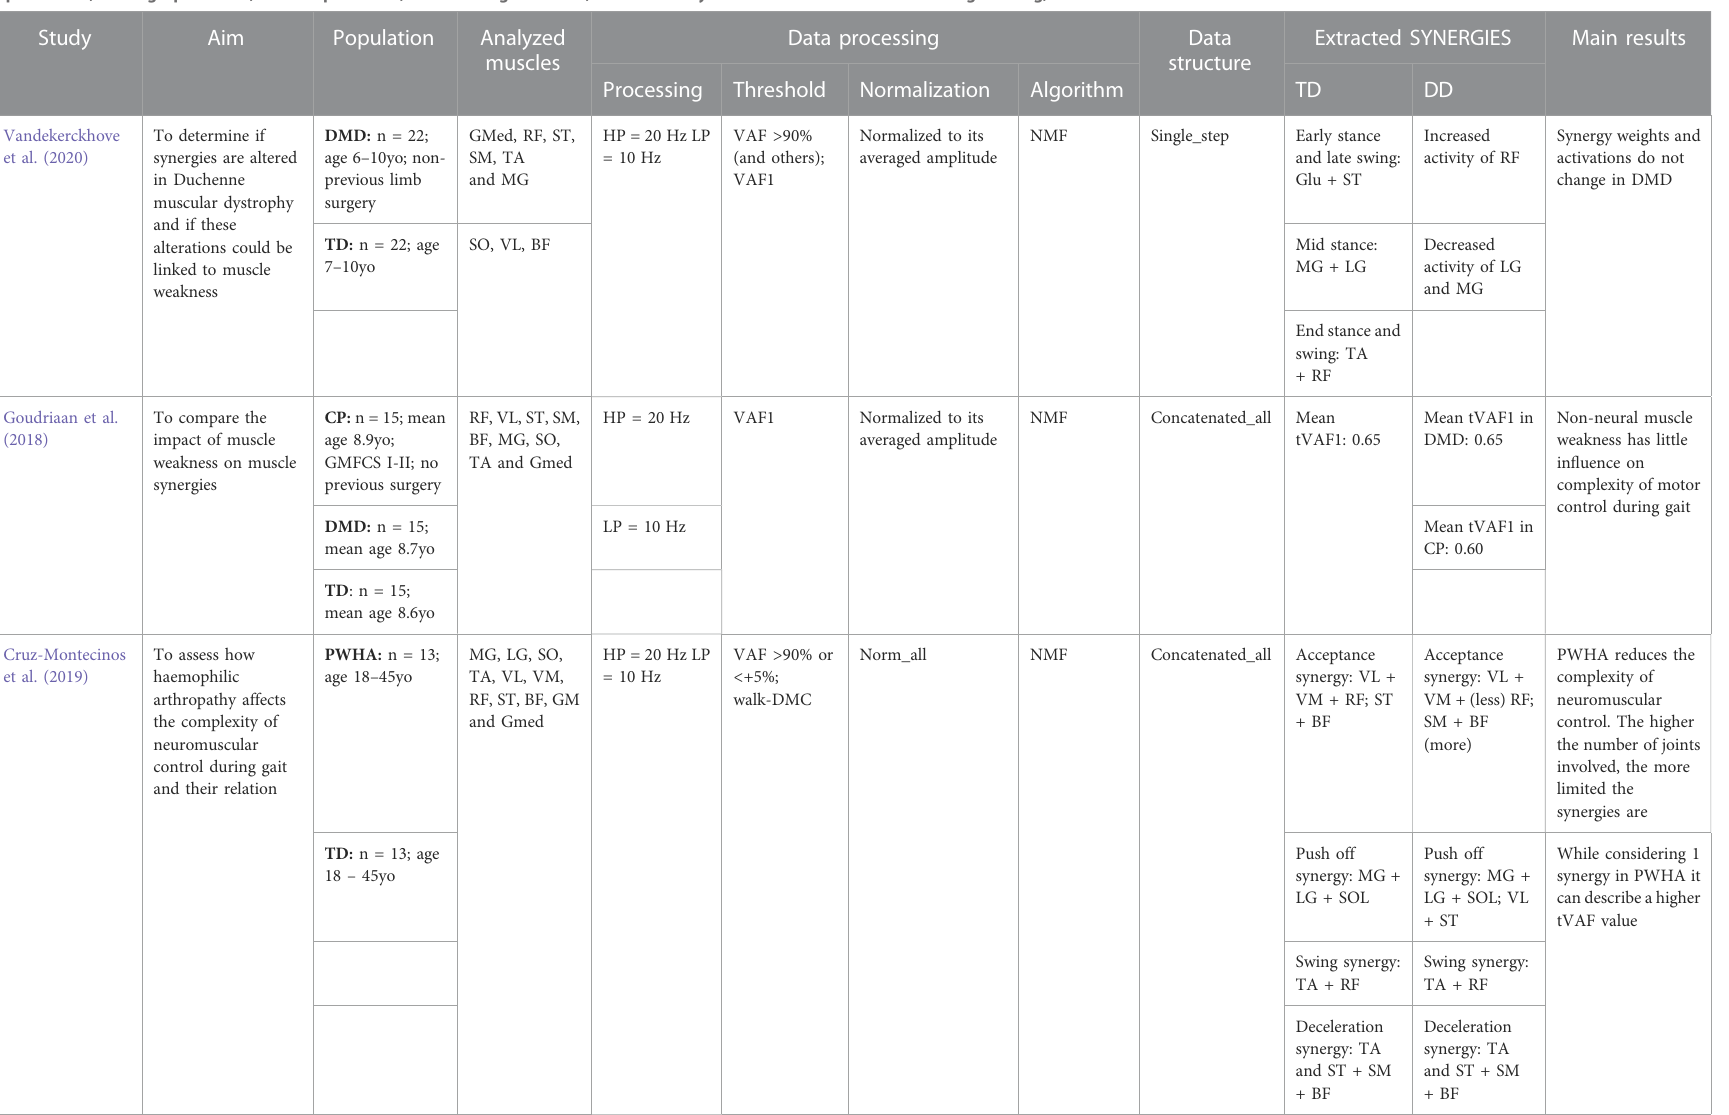
TABLE 3 Aim of the study, population, analyzed muscles, data processing, data structure, extracted synergies, main results of the articles investigating how muscle synergies vary in children affected by other developmental diseases in respect to healthy controls. Acronyms: DMD: Duchenne muscular dystrophy, CP: cerebral palsy, PWHA: people with hemophilic arthropathy, ISCI: Incomplete Spinal Cord Injury, ID: intellectual disability, DS: Down Syndrome, TD: typical development, GMFCS: Gross Motor Function Classi fi cation System, GM: gluteus maximum; Gmed: Gluteus medius; BF: biceps femoris; ST: semitendinosus; SM: semimebranosus; RF: rectus femoris; VL: vastus lateralis; VM: vastus medialis; TA: tibialis anterior; SO: Soleus; ES: erector spinae; MG: medial gastrocnemius; LG: lateral gastrocnemius; RA: rectus abdominis, NMF: Non-negative matrix factorization, RMSE: Root